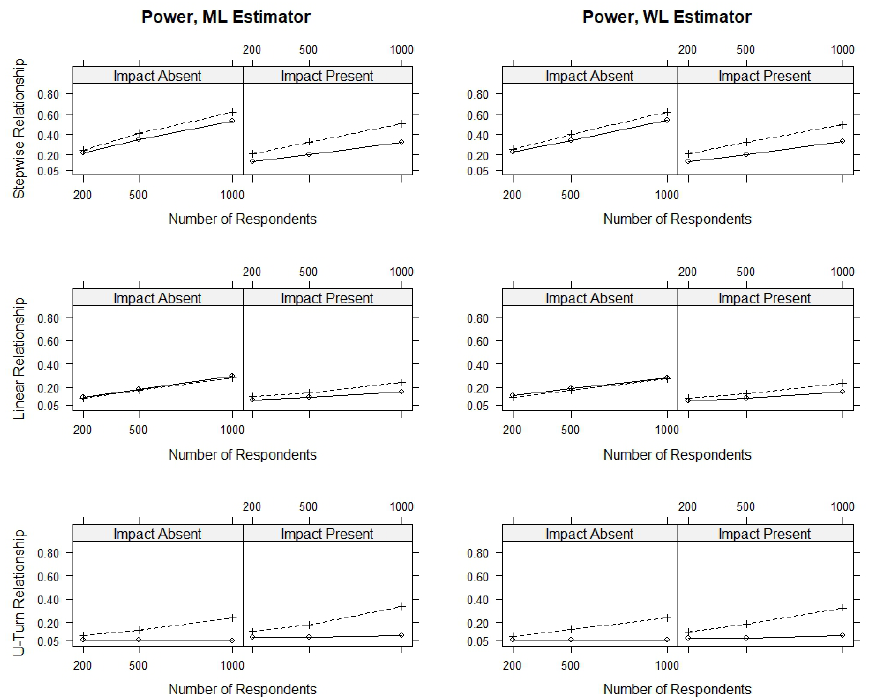
Figure A8. Power of two tests against unbalanced DIF in the β parameter for modules of 18 items. Only items suspected to be DIF-free are used for ability estimation. The unbroken line presents the results for the linear logistic regression test, the broken line presents the results for the score-based bootstrap